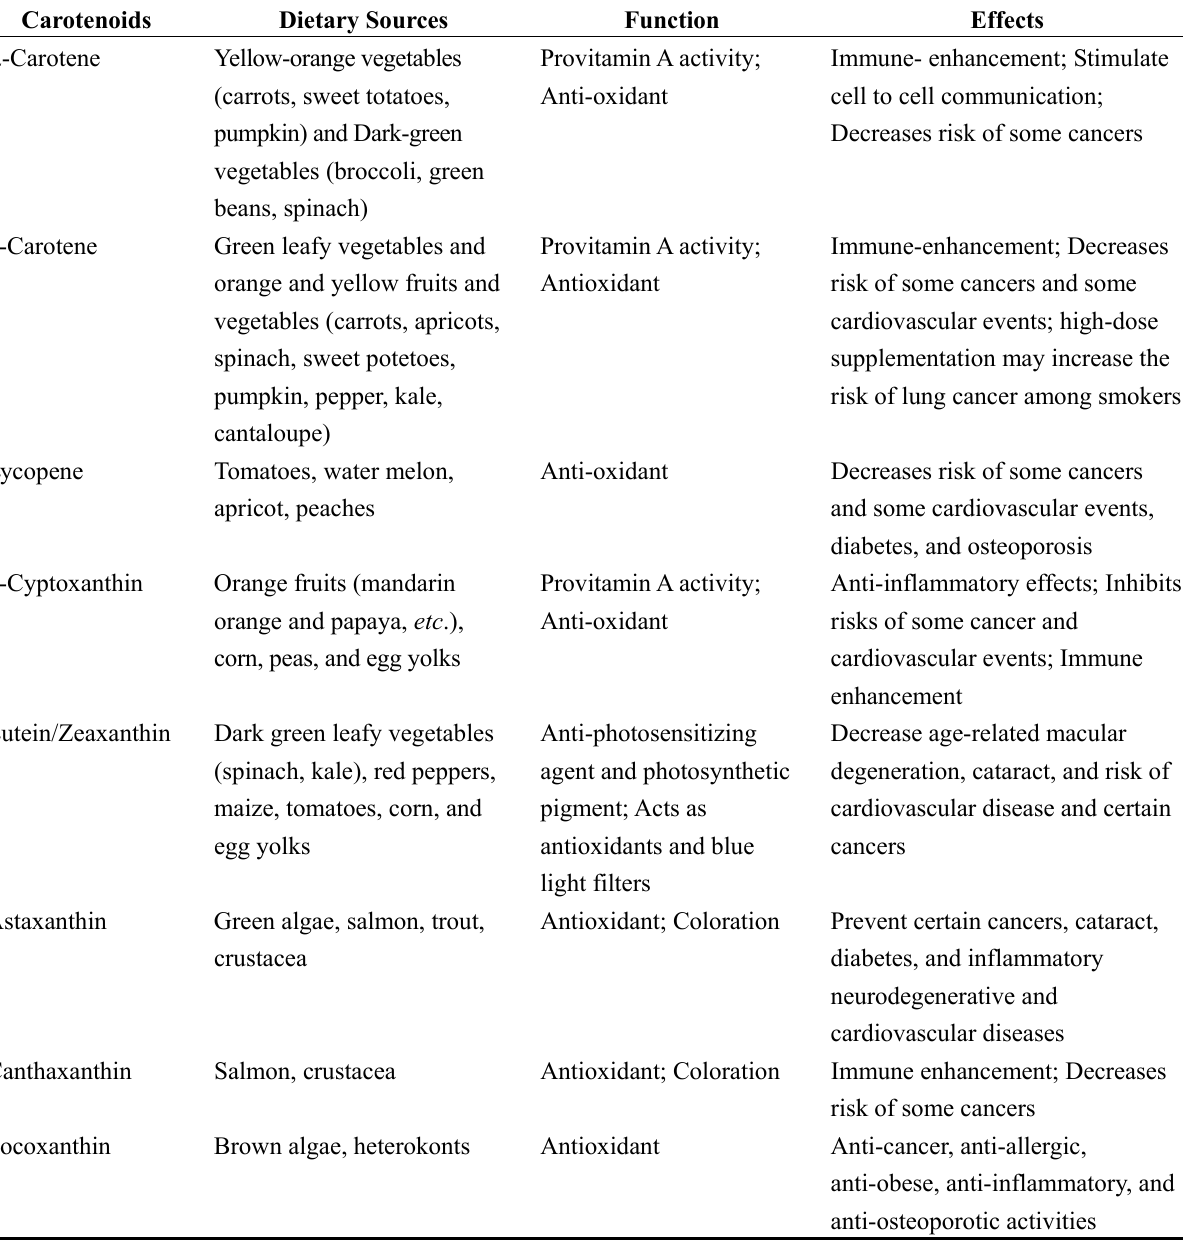
Table 1. Sources, function, and effects of different